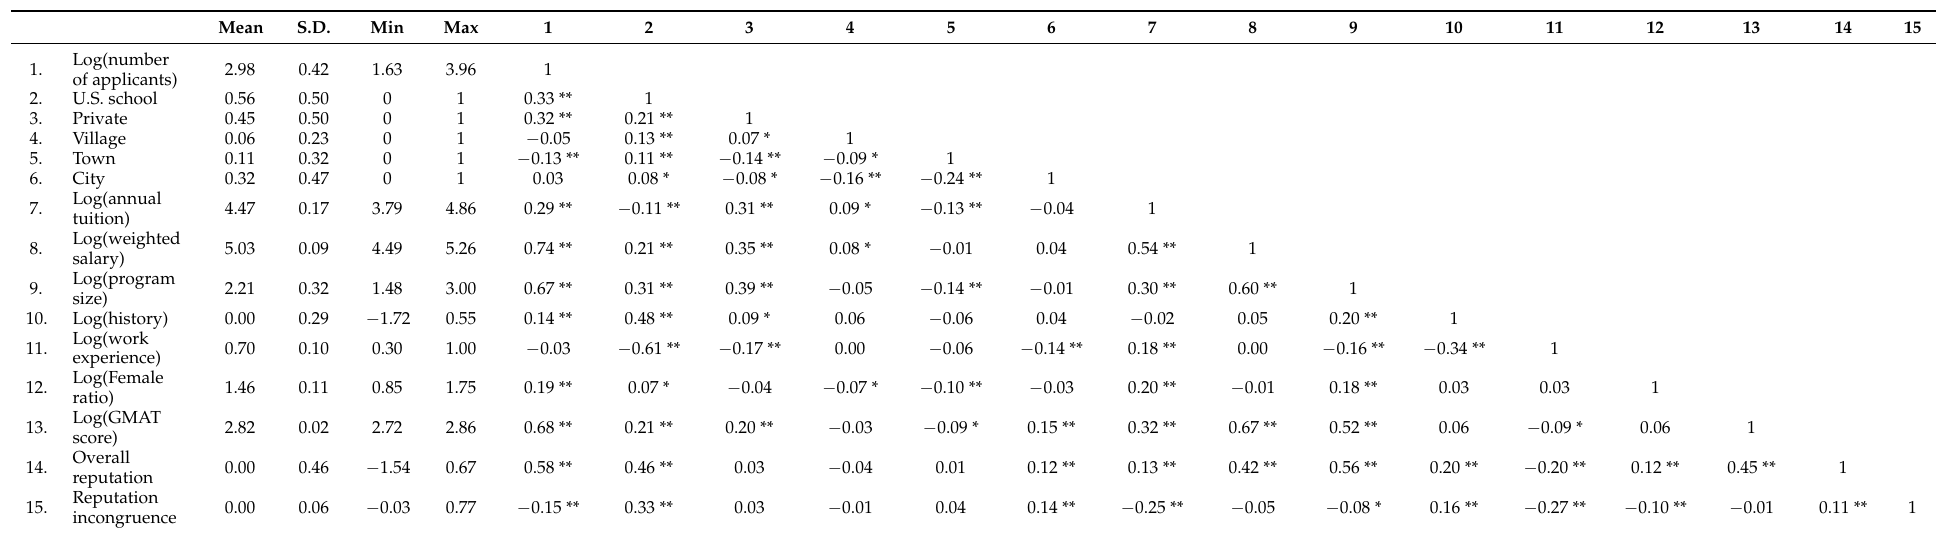
Table 2. Descriptive statistics and correlation coefficient in the models for prospective students (N =